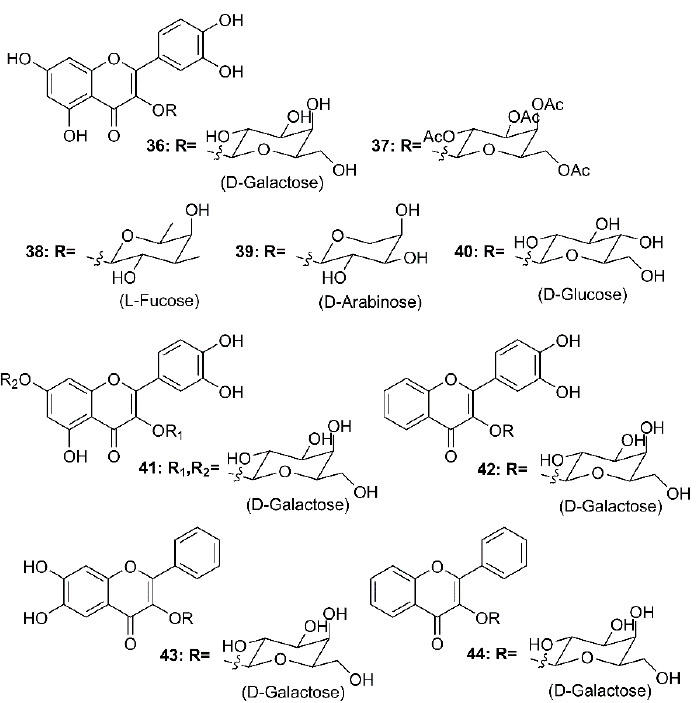
Figure 7. Structures of quercetin-3- β - D -galactoside ( 36 ) and its synthetic derivatives 37 – 44 . Twelve geranylated flavonoids, including tomentins A–E ( 45-49 ), 3 ′ - O -methyl- diplacol ( 50 ), 4 ′ - O -methyldiplacol ( 51 ), 3 ′ - O -methyldiplacone ( 52 ), 4 ′ - O -methyldiplacone ( 53 ), mimulone ( 54 ), diplacone ( 55 ) and 6-geranyl-4 ′ ,5,7-trihydroxy-3 ′ ,5 ′ -dimethoxyfla- vone ( 56 ) (Figure 8) were isolated from the methanolic extract of fruits of a Chinese me- dicinal plant, Paulownia tomentosa (Thunb.) Steud. (Paulowniaceae) . Compounds 45-56 in- hibited papain-like protease (PL pro ) activity in a reversible, mixed-type mode, with IC 50 values ranging from 5.0–14.4 μ M (Table 2) [34].